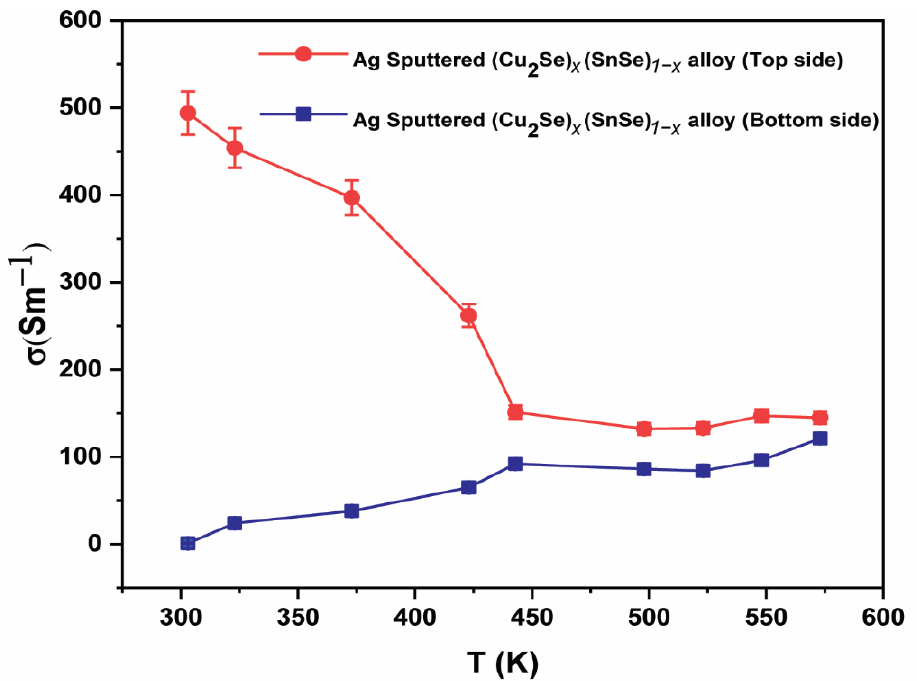
Figure 3. The electrical conductivity measured from both sides of the (Cu 2 Se) 0.005 (SnSe) 0.995 +Ag alloy (top and back/bottom sides).